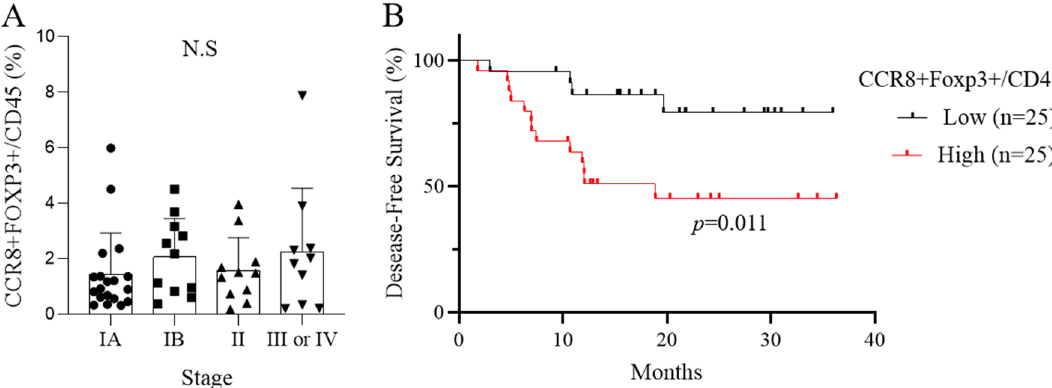
Figure 2. Frequency of CCR8+ Tregs is associated with patient prognosis but not tumor stage. ( A ) Percentages of CCR8+ FOXP3+ cells in CD45+ cells in lung tumors based on clinical stage (n = 50). Statistical significance was determined by one-way ANOVA Kruskal–Wallis test followed by Dunn. ( B ) Kaplan–Meier analysis of disease-free survival based on the level of CCR8+ Tregs. Lung cancer patients (n = 50) were divided into high and low CCR8+ Treg groups based on the median percentage of CCR8+ FOXP3+/CD45+ cells in TICs. Statistical significance was determined by the log-rank (Mantel–Cox)